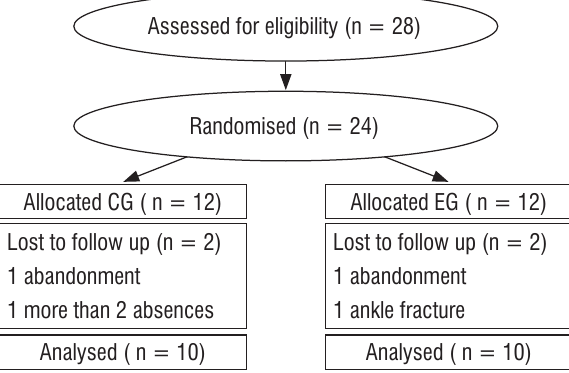
Figure 1 - Flow diagram of the progress through the phases of a parallel randomised trial of two intervention groups. Salvador, Brazil,